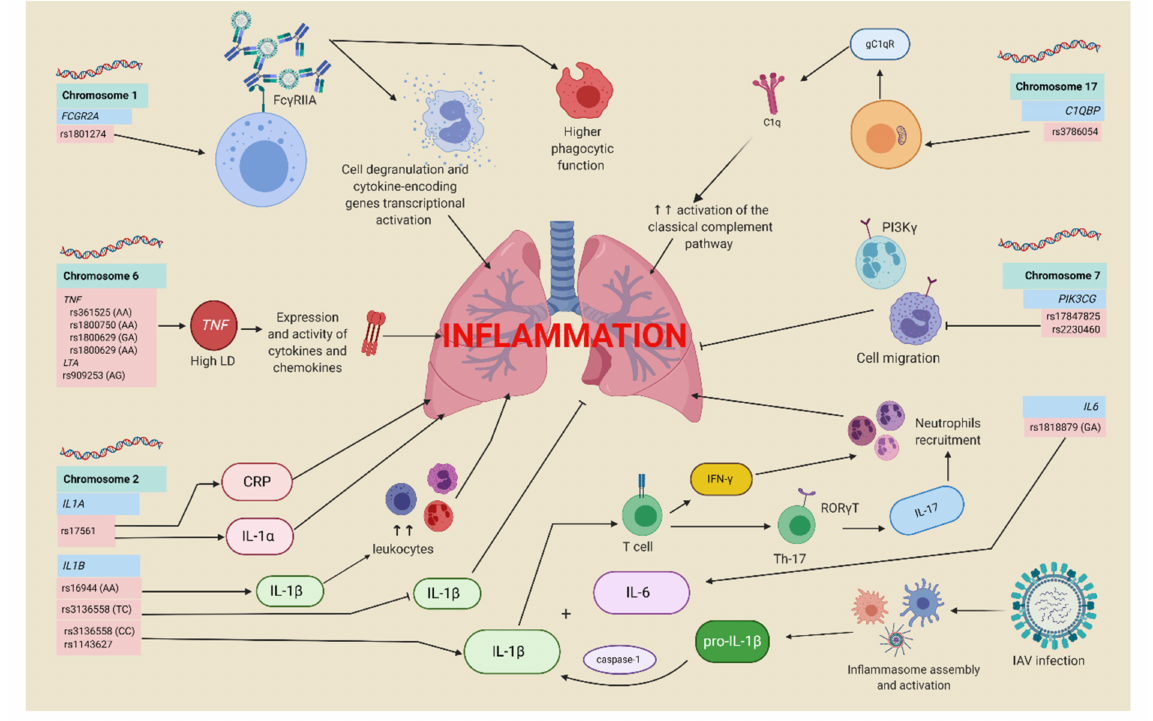
Figure 4. Graphical summary of genetic polymorphisms and their participation in IAV infection. Created with